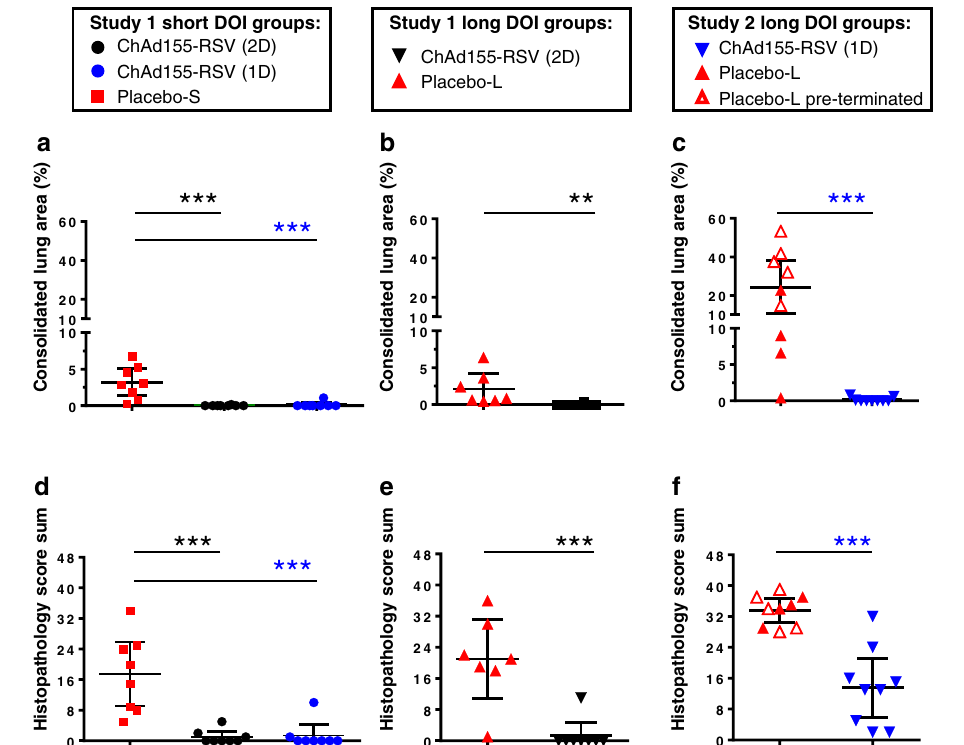
Fig. 3 | Lung pathology. Calves ( n =7 to 9 biologically independent animals, see Table 1) received a single or two doses (1D or 2D, respectively) of ChAd155-RSV vaccine or placebo, followed by a short (4 weeks) or long (16 weeks) duration of immunity (short DOI or long DOI, respectively) and then a bovine RSV challenge. Placebo-Sandplacebo-Lgroupsindicatethecontrolgroupssubjectedtotheshort- DOI and long-DOI regimens, respectively. On day post-challenge (dpc) 12/13 ani- mals were subjected to necropsy. Macroscopic analysis of the consolidated lung areas (CLAs; a – c ) and sums of lung pathology scores determined by microscopic analysis of the lung pathological changes ( d – f ) are presented for the study groups indicated in the keys above the graphs. Sums of lung pathological scores were